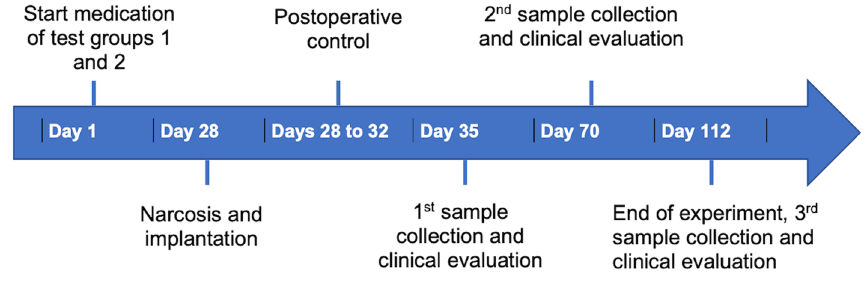
Figure 1. Timeline of the